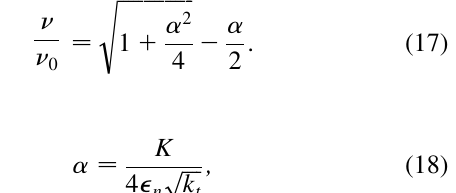
FIG. 6. Perveance ratio and tune depression as a function of is initial transport lattice period. K i